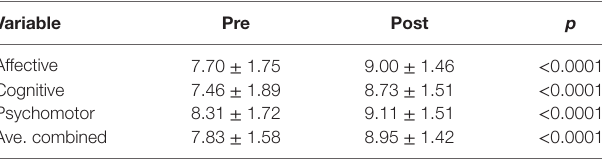
TaBle 2 | Pre and post learner confidence in management of postpartum hemorrhage (value ± SD).